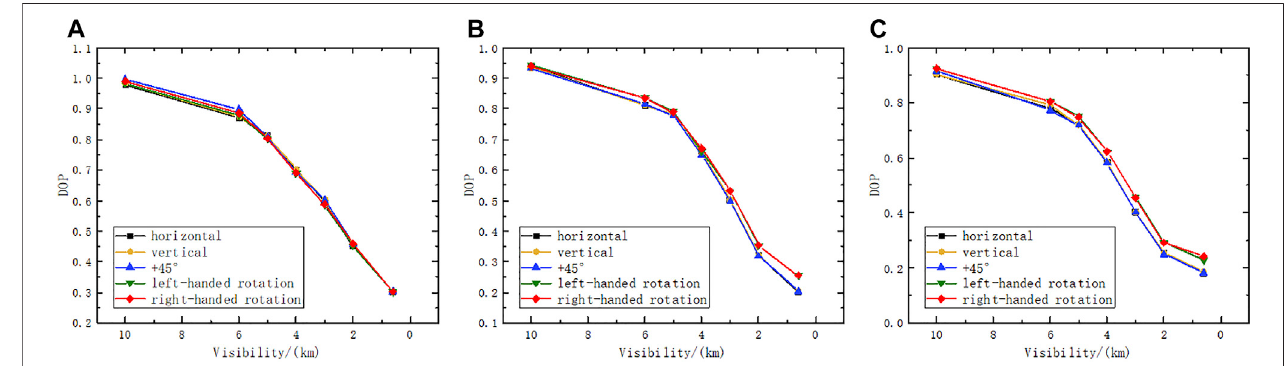
FIGURE 7 | Field test curves of polarization transmission characteristics at different wavelengths: (A) 450 nm, (B) 532 nm, and (C) 671